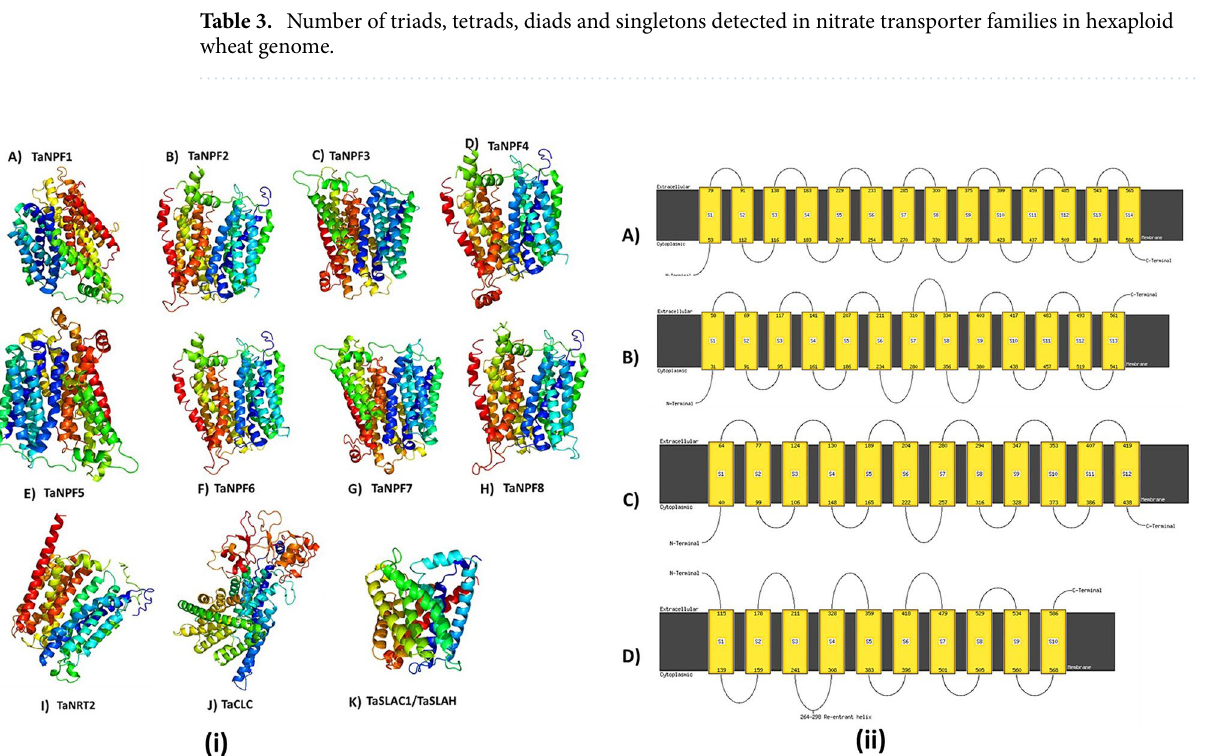
Figure 4. Protein structure prediction: (i) representative structures of TaNPF genes ( A – H ), TaNRT2 genes ( I ) TaCLC genes ( J ) and TaSLAC1/TaSLAH genes ( K ). (ii) Representative TMs structures of nitrate transporters containing ( A ) 14 TMs, ( B ) 13 TMs ( C ) 12 TMs and ( D ) CLC proteins containing 10 TMs and a re-entrant helix. Figures were developed by homology-based modelling by Phyre2 server 41